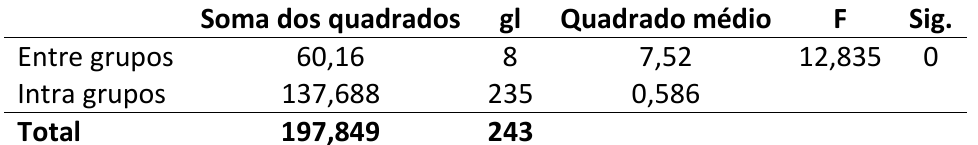
Table 4. ANOVA results for the centroid size of every group ( gl : degrees of freedom, quadrado médio : division of the squares by gl